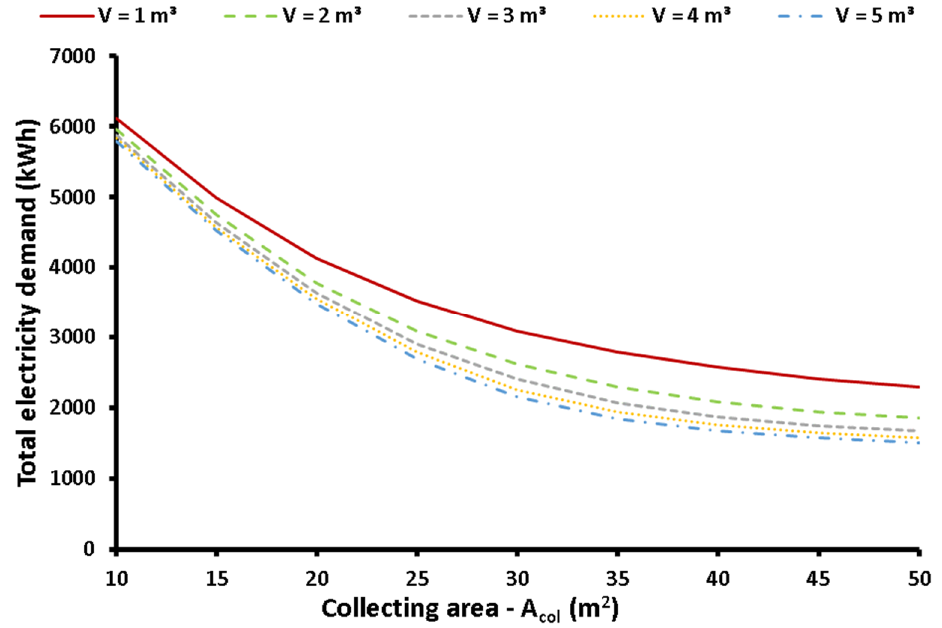
Figure 12. Total electricity demand (compressor and auxiliary electrical resistance) for different combinations of (A col ) and (V).